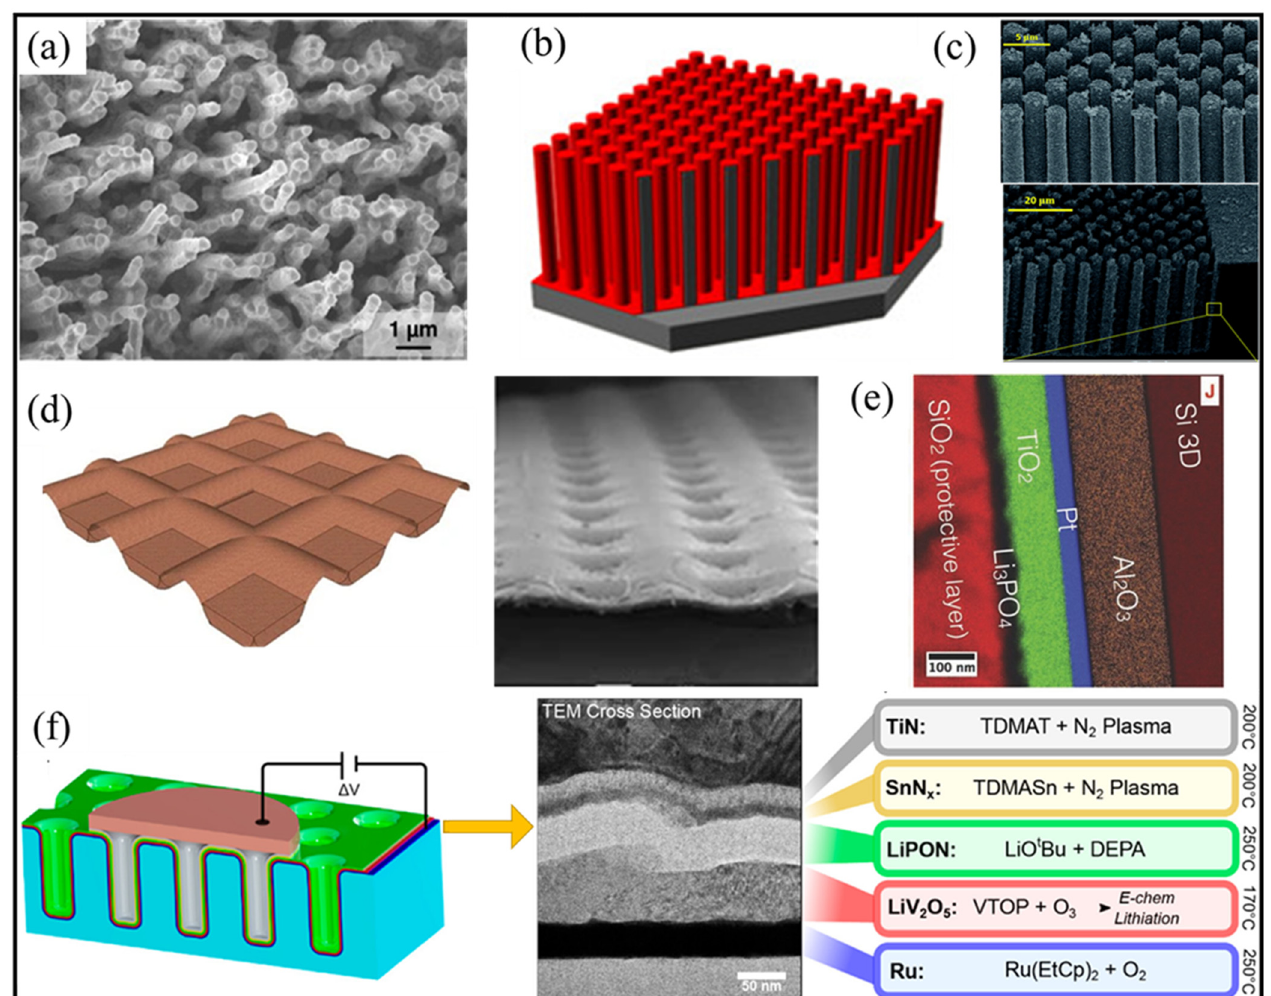
Figure 10. 3D structures. ( a ) SEM image of aluminum nanorods directly grown on Al substrate [312]; ( b ) 3D VO x film on Si pillars [313]; ( c ) SEM images of Ni/LMO on the TiN-coated Si microstructured substrate [314]; ( d ) 3D schematic illustration of the as-fabricated check-patterned Cu foil (left) and SEM images of Si electrodes on patterned Cu foil (right) [316]; ( e ) Layer interfaces EDX-STEM elemental map of the stacked layers consisted of Si-3D/Al 2 O 3 /Pt/TiO 2 /Li 3 PO 4 /SiO 2 -Li 3 PO 4 layer [317]; ( f ) Ba tt eries testing through contact with the top electrode and cathode current collector layers (left), cross-sectional TEM image and overview of all-ALD solid-state ba tt eries with 40 nm Ru/70 nm LiV 2 O 5 /50 nm Li 2 PO 2 N/10 nm SnN x /25 nm TiN (right) [192].